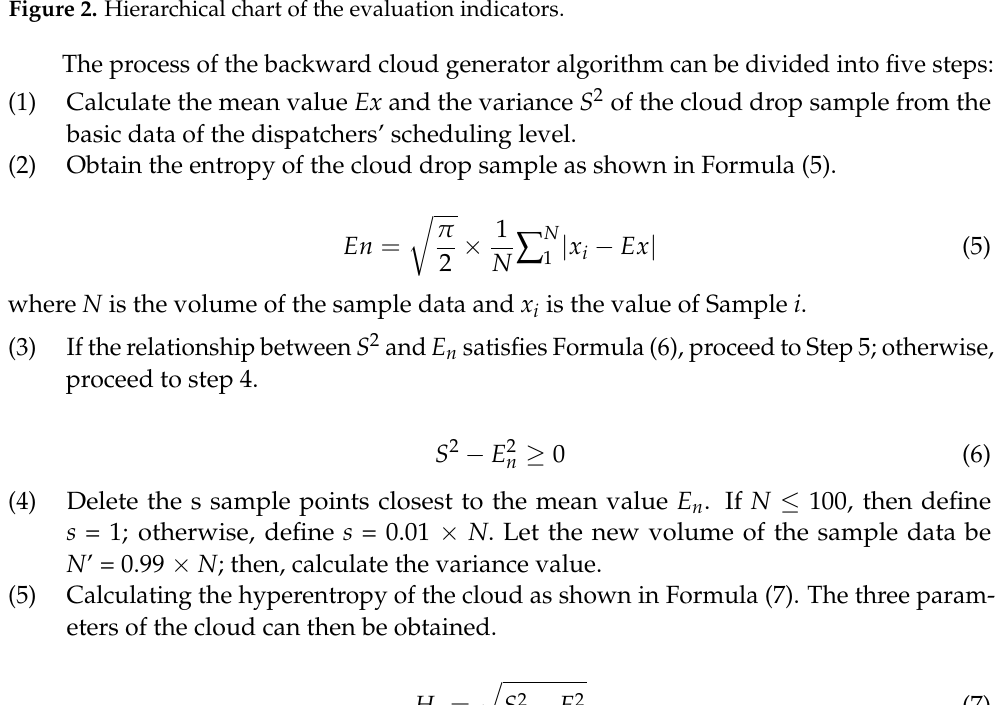
Figure 2. Hierarchical chart of the evaluation